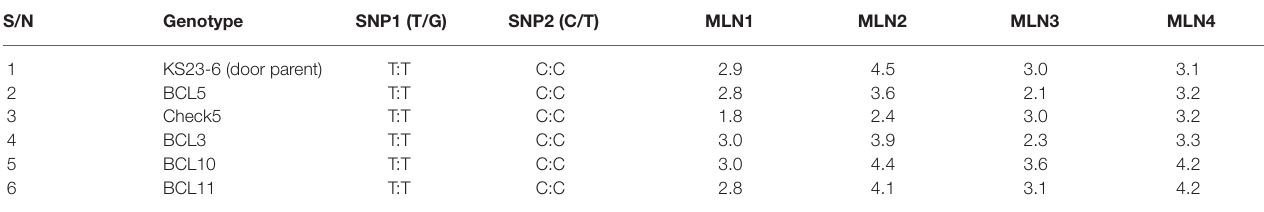
T:T and C:C indicate MLN resistant loci for SNP1 and SNP2.